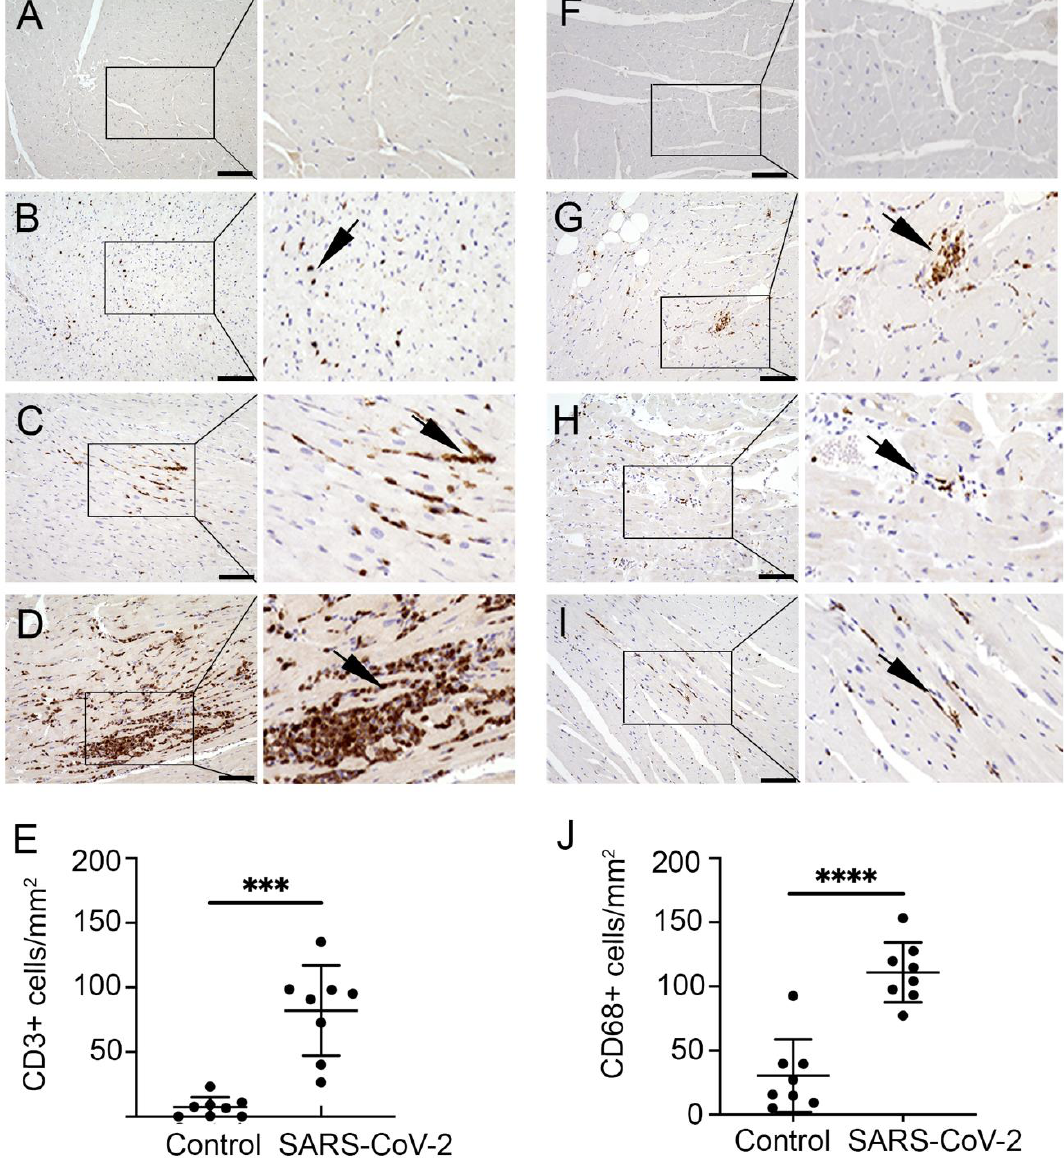
Figure 3. SARS-CoV-2 infected monkeys exhibit increased myocardial T lymphocyte and macro- phage infiltration. Representative microscopic images show immunohistochemical (IHC) staining with CD3 antibody on cardiac tissue of ( A ) CRTL 1, ( B ) AGM2, ( C ) AGM4, and ( D ) AGM1. CD3+ cells (brown) were marked diffusely throughout the myocardium as well as in varying degree of infiltrates (arrows). ( E ) Graph shows quantification of CD3 cells in control (mean 7.34 ± 7.72